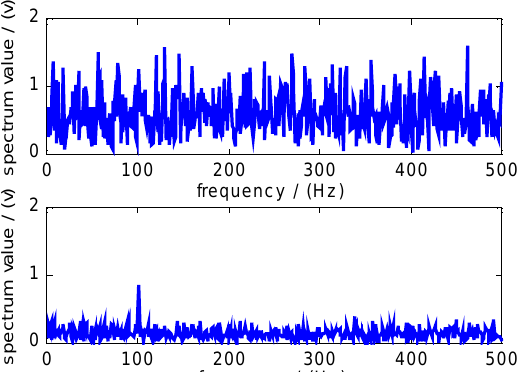
Figure 1. Input signal spectrum (upper figure) and output response spectrum (lower figure) of SR system when signal amplitude A =0.1V, frequency f =100Hz, noise intensity D =0.5, and